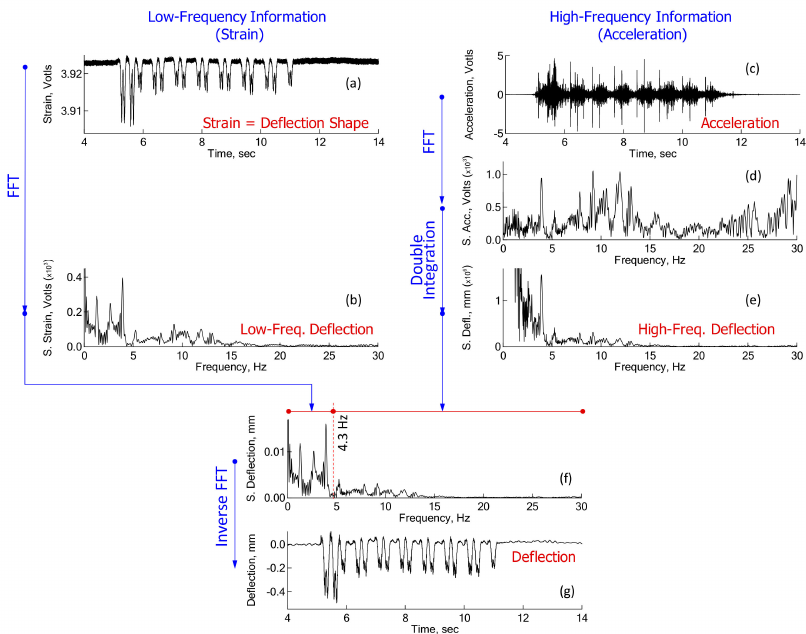
Figure 5. Illustration of the PDM applied to a passenger train: ( a ) Measure strain history, ( b ) Strain spectrum from FFT, ( c ) Measures acceleration history, ( d ) Acceleration spectrum from FFT, ( e ) Deflection spectrum from double integration of acceleration, ( f ) Combined deflection spectrum, and ( d ) Deflection history from inverse FFT of combined deflection